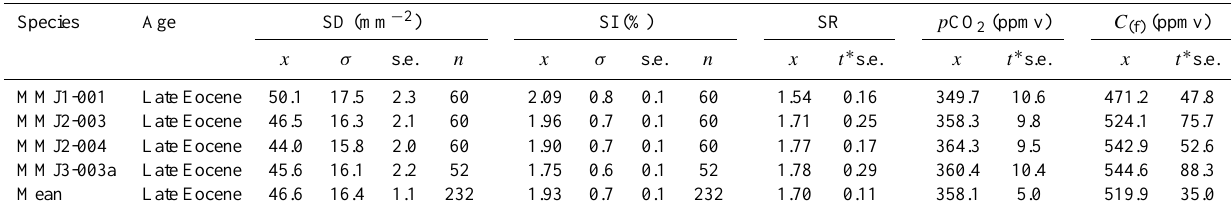
Table 8. Summary of stomatal parameters of the combined data of the adaxial and abaxial surfaces of fossil Nageia and p CO 2 [ C (f) ] estimates